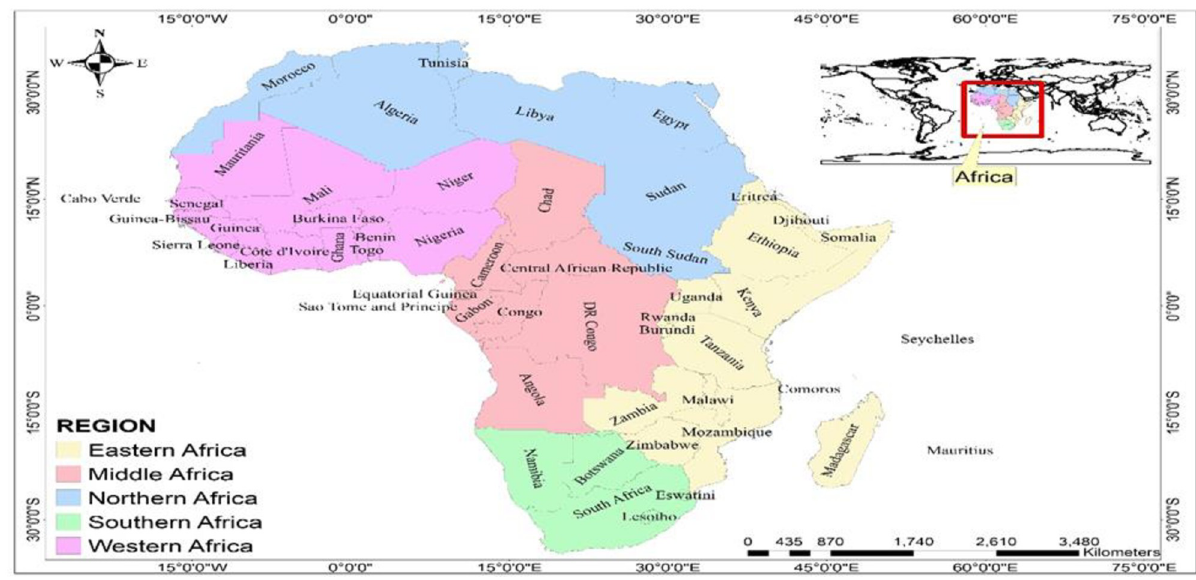
Fig 1. Map of study countries (reprinted from https://tapiquen-sig.jimdofree.com/descargas-gratuitas/mundo/, under a CC BY license, with permission from Carlos Efrain Porto Tapiquen, 2021).